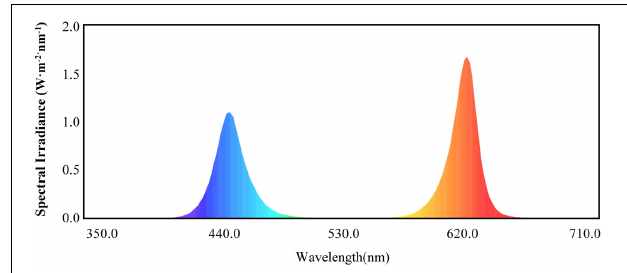
FIGURE 1 | Red and blue (7R2B) LED plant growth light